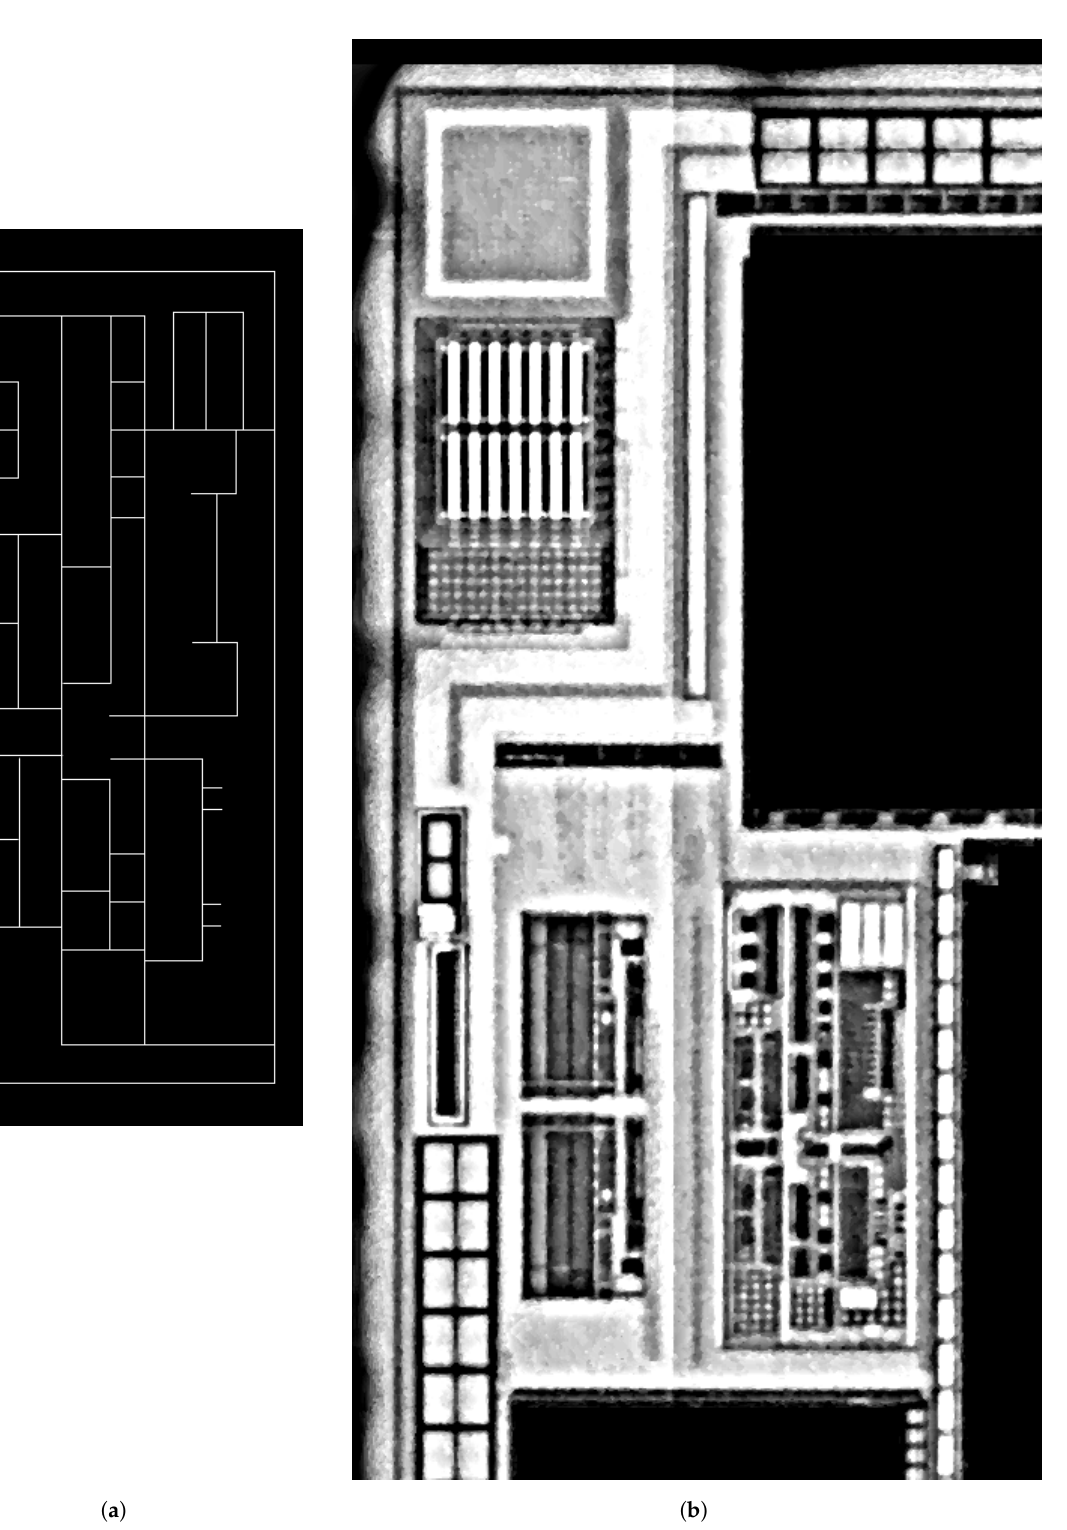
Figure 12. A schematic template ( a ) to match and locate in the target image acquired under a 20 × optical magnifier ( b